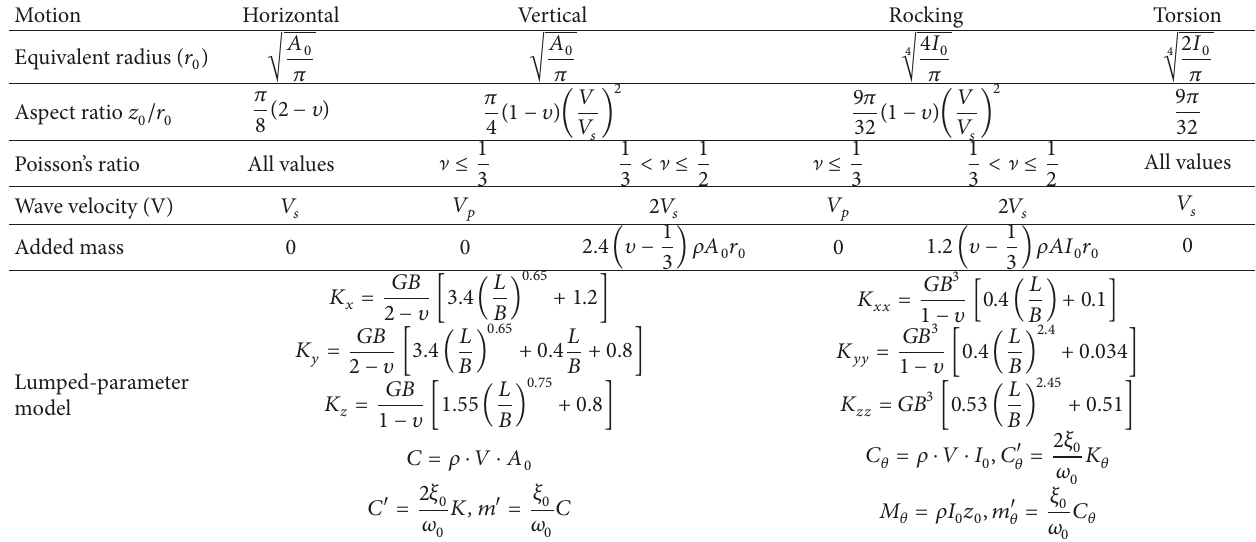
Figure 3: Cone model layout and equivalent lumped elements for soil replacement model. Table 1: Con model of properties of the rectangular foundation on a homogeneous half-space [33].